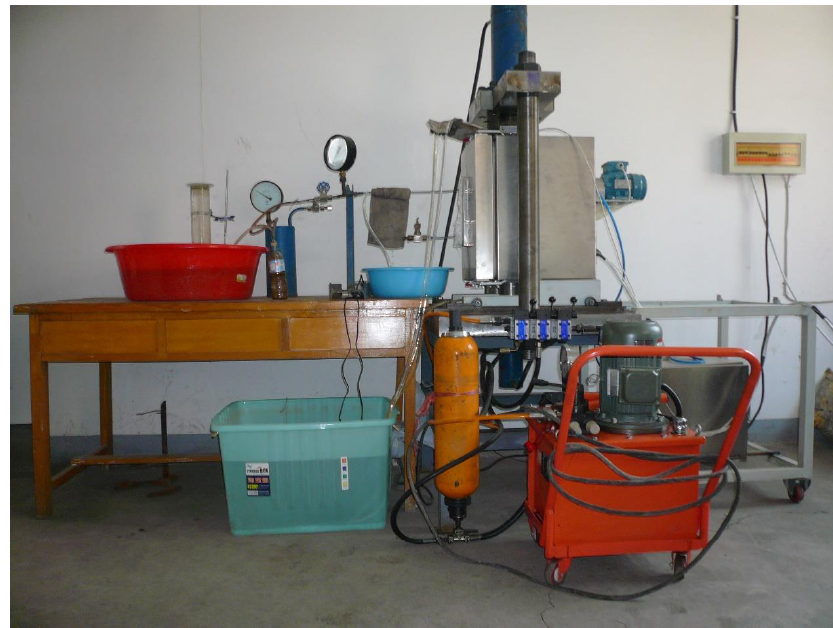
Figure 3. Picture of the experimental apparatus used in this study.